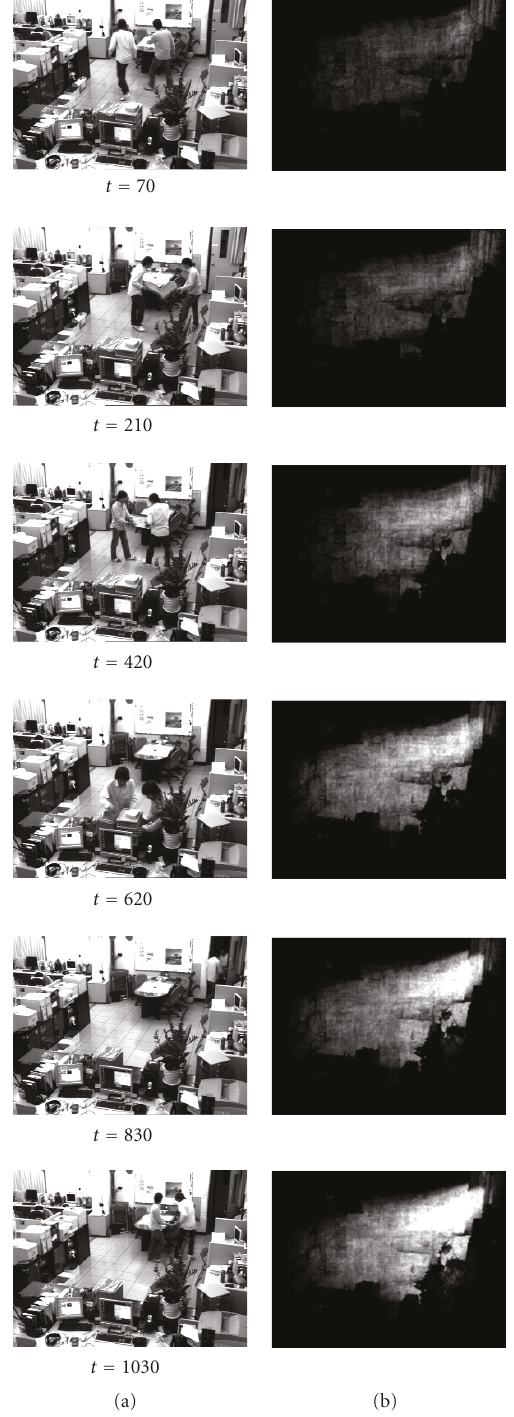
Figure 6: Abnormal event of a moving-furniture scenario: (a) discrete image frames in the sequence; (b) corresponding energy maps.